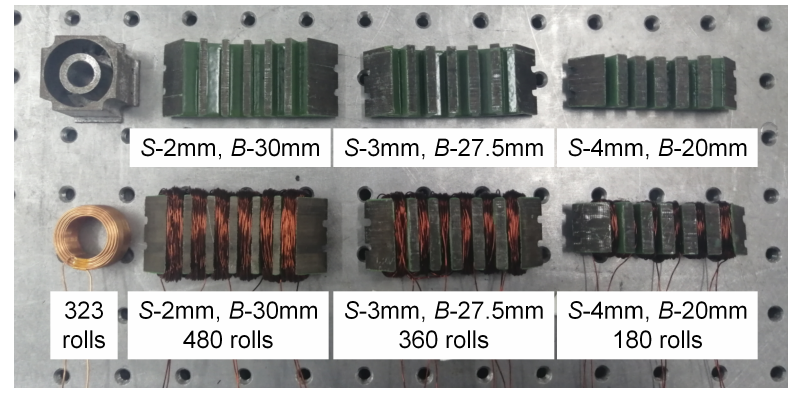
Figure 9. Parts of the reaction sphere prototype for constraints and masses validation.